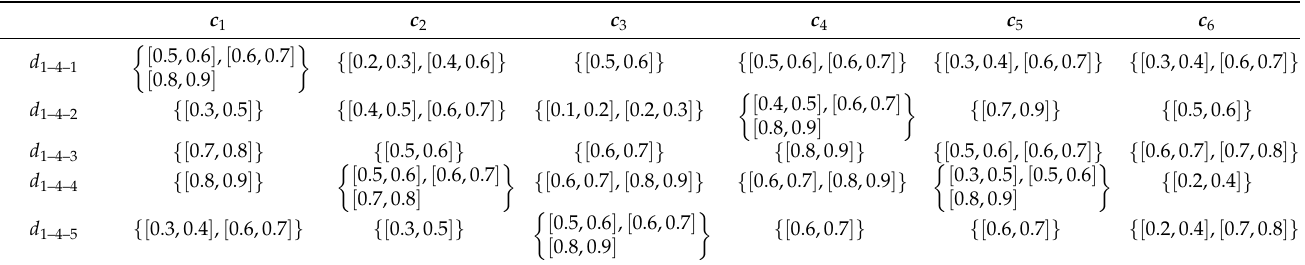
Table A4. Scoring matrix of asset management status d 1–4 .